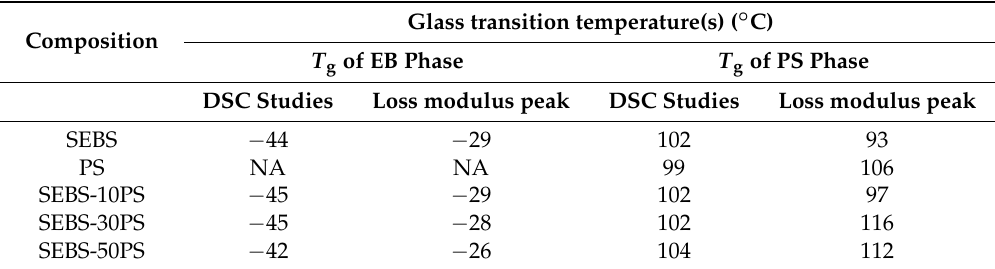
Figure 7. ( a ) Differential scanning calorimetry curves and ( b ) TGA curves. Table 2. Comparison of T g values obtained from DSC plots and loss modulus